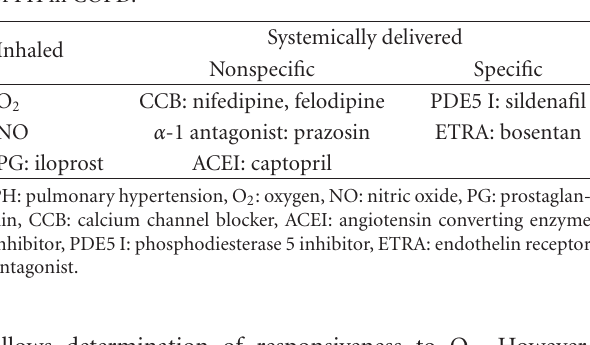
Table 5: Various pulmonary vasodilators studied for the treatment of PH in